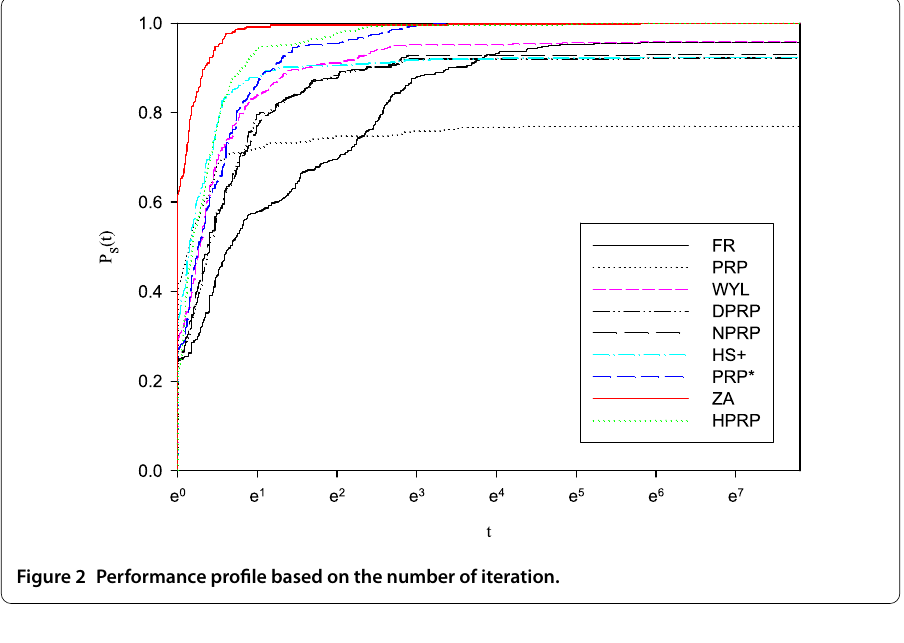
Figure 2 Performance profile based on the number of iteration.